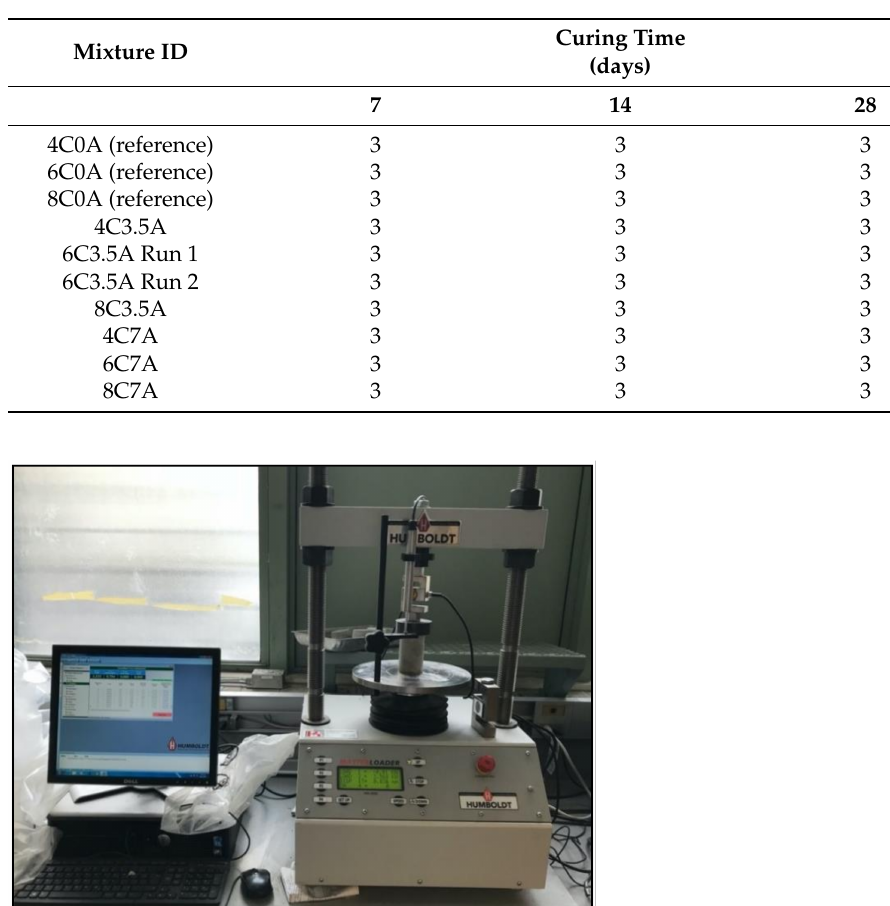
Table 6. Number of backfill specimens subjected to unconfined compressive strength (UCS) testing (see Table 5 for mixture IDs).